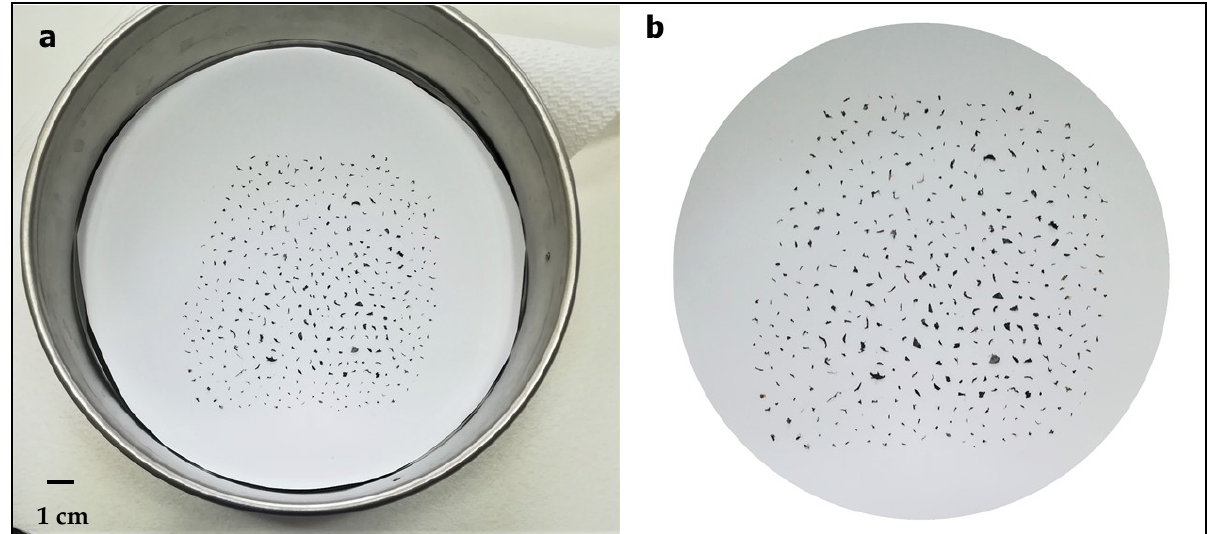
Figure 2. Image preprocessing steps: ( a ) Picture of an MPs sample in the sieve; ( b ) The same picture cropped.